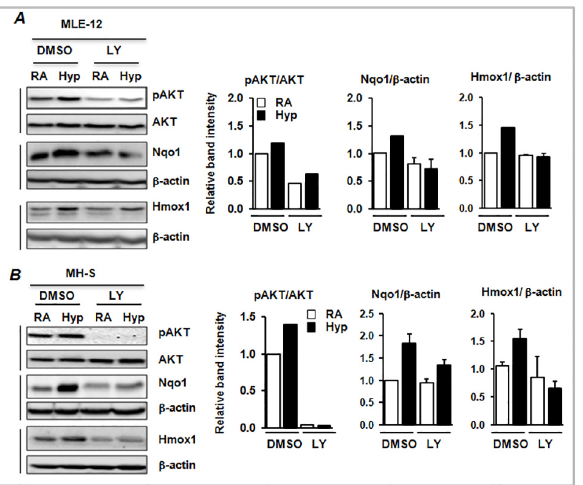
control (scrambled)-siRNA transfected counterparts. Hyperoxia-induced Hmox1 expression, but AKT1 knockdown had no significant effect on the expression levels of Hmox1 (Fig 4B). Hyperoxia-induced GPX2 expression was modestly reduced in AKT1 siRNA transfected